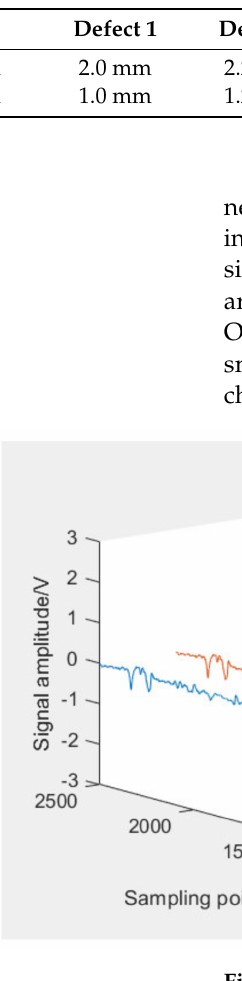
Figure 13. Multichannel original MFL signal.